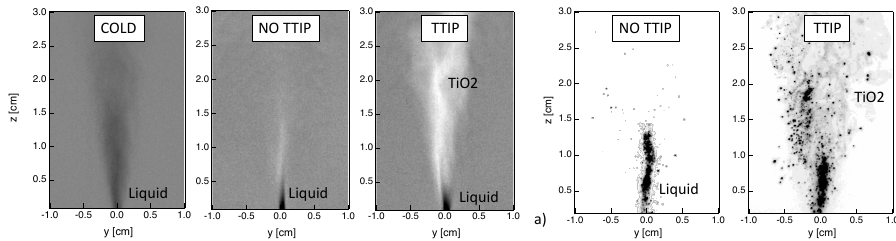
Figure 3. Instantaneous images obtained by ( a ) shadowgraphy and ( b ) light scattering, without and with injection of TTIP. Results for the non-reacting cold case with shadowgraphy are also presented. In the reactive case, with the injection of TTIP, spots of light due to diffraction of partially transparent TiO 2 nanoparticles can also be observed. Then, it is possible to discriminate spray from TiO 2 nanoparticles by considering dark or bright